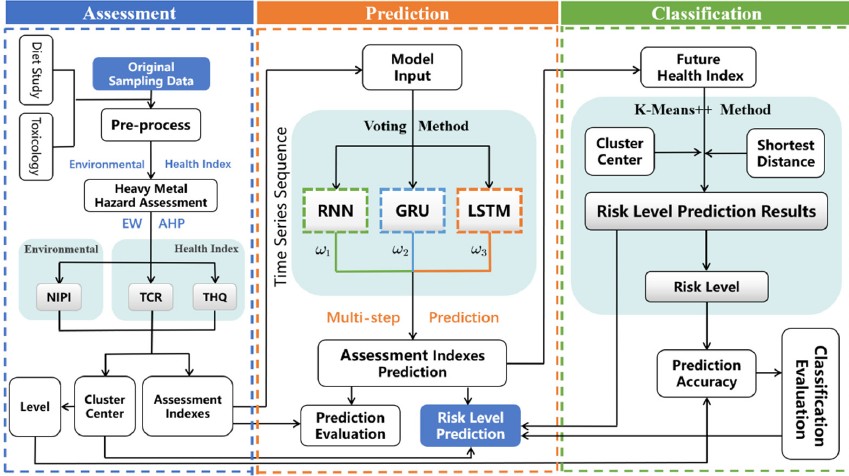
Figure 1. Framework of the classification and prediction of food safety risk level.